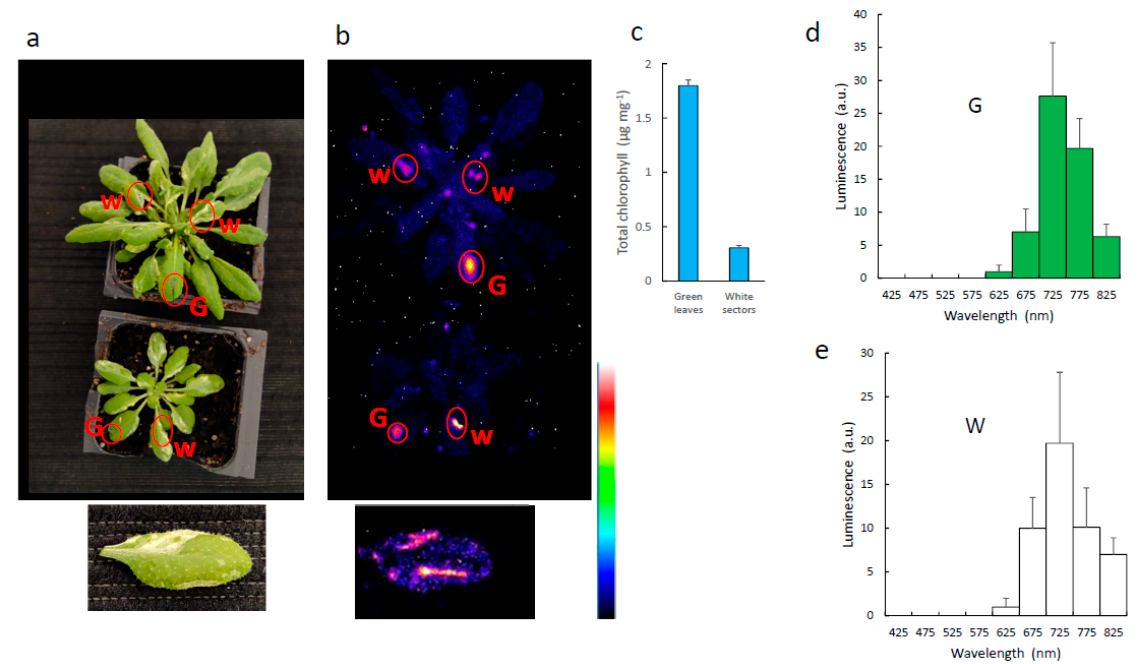
Figure 4. Wounding-induced SCL emission from leaves of the variegated thf1 Arabidopsis mutant. ( a ) Picture of thf1 plants. Green (G) and white (W) leaf sectors were wounded with tweezers. ( b ) SCL image of the plants. At the bottom of panels ( a , b ), there is a close-up shot of a thf1 leaf. One incision has been made with a scalpel on the green and the white parts of the leaf. ( c ) Chlorophyll is drastically decreased in the white sectors of thf1 leaves. ( d , e ) SCL spectrum of wounded green and white leaf sectors.